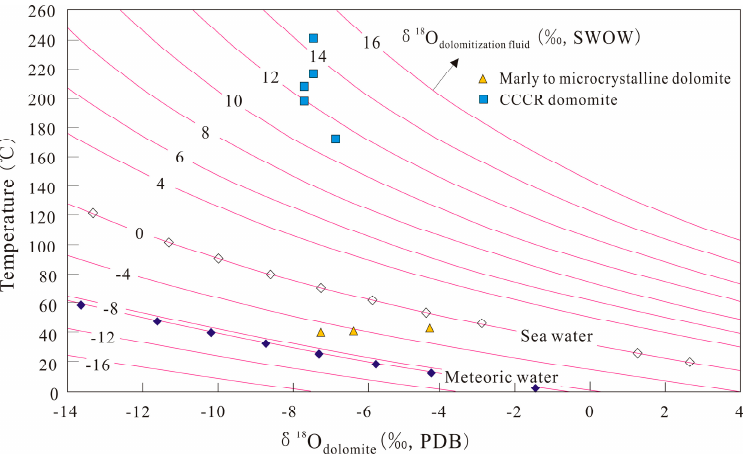
Figure 10. Relation between the oxygen isotope composition and inclusion homogenization temperatures in dolomite (the errors are smaller than the symbols). Contours represent the oxygen isotope composition of dolomitization fluid, calculated by the formula from Horita (2014) [75]. The contour line with hollow diamond points is the δ 18 O curve for global Triassic seawater, assuming a global Triassic seawater value of 0‰ (standard mean ocean water (SMOW)) [78]; The contour line with solid diamond points is the δ 18 O curve of meteoric water with an average of − 8.35‰ (SMOW) [79].